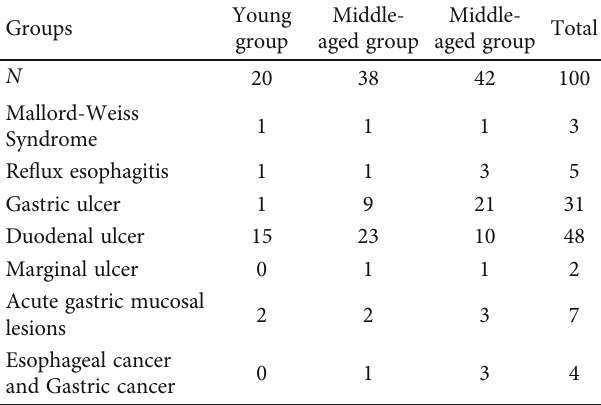
Table 1: Forrest grading of peptic ulcer. Forrest grading